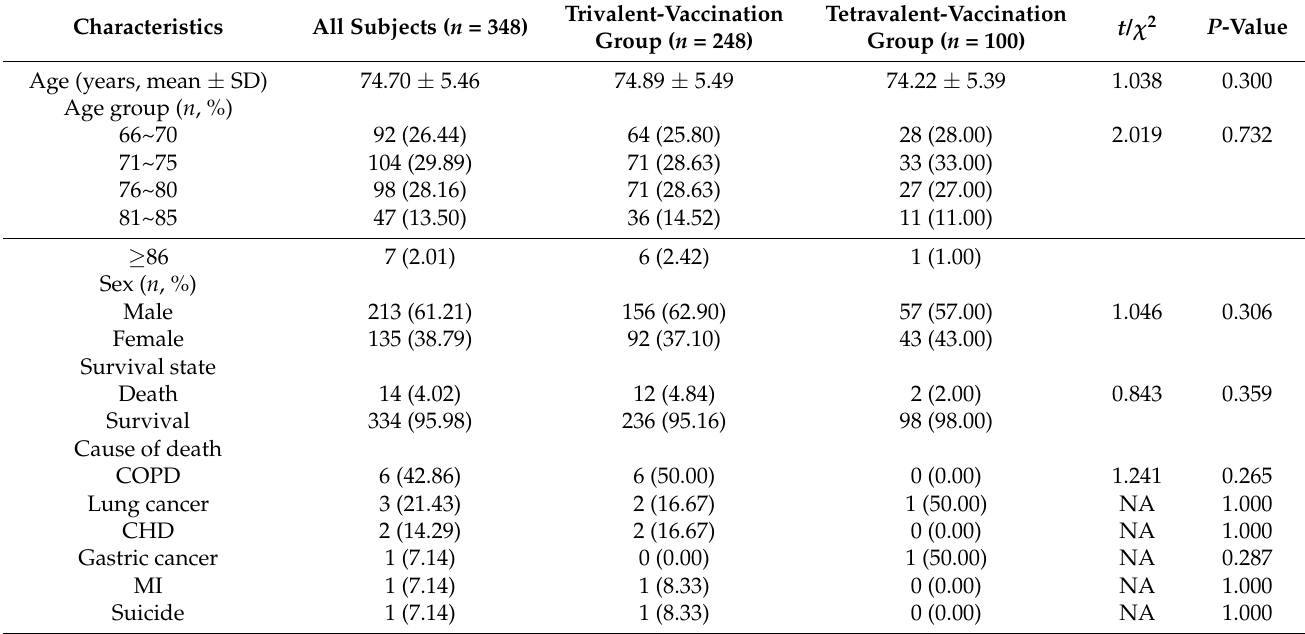
*: Represents patients who had acute attacks as long as there were records in the outpatient or inpa- tient department. # : Represents the sum of outpatient and hospitalization expenses.